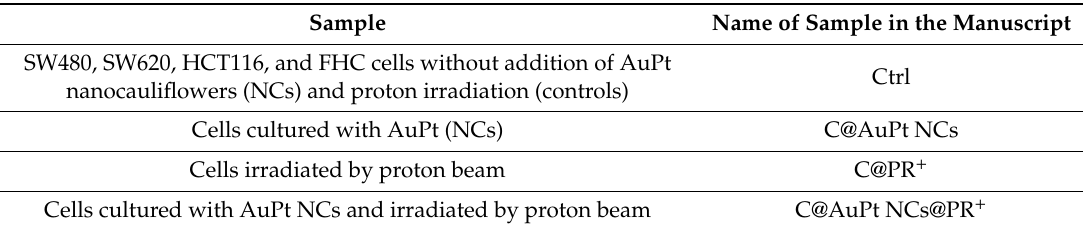
Table 1. Description of the investigated